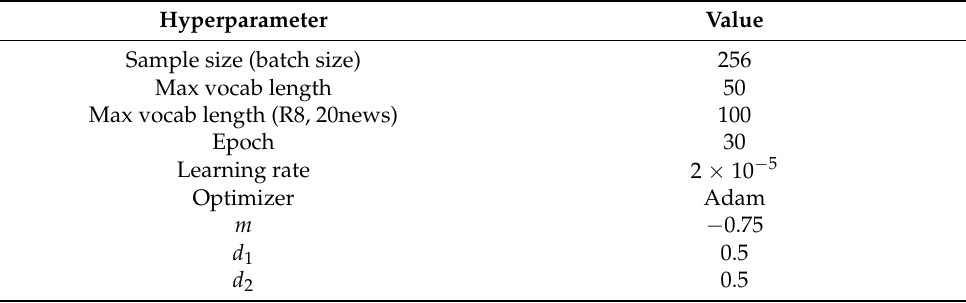
Table 2. Hyperparameter setting in experiment.